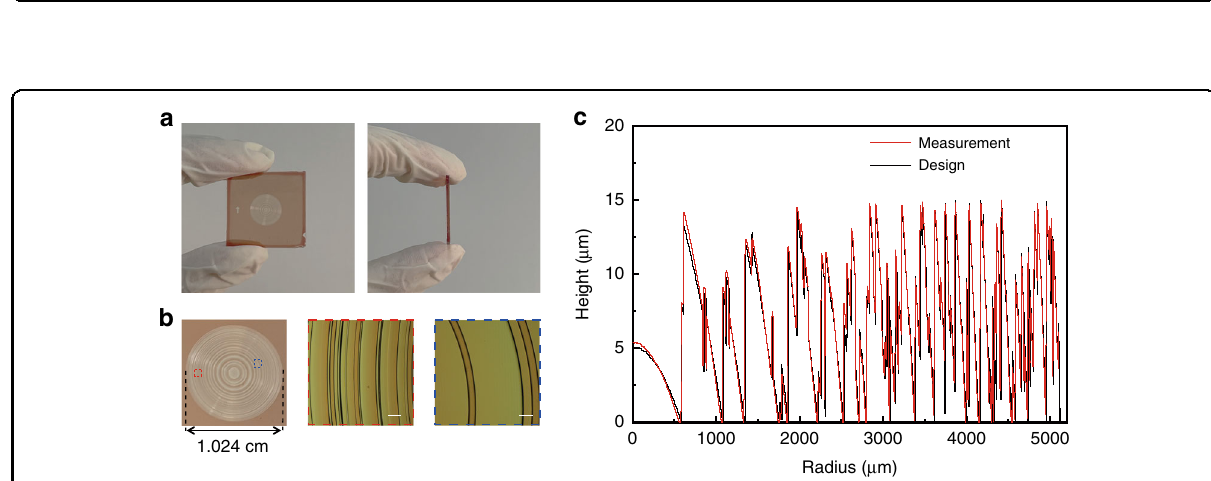
Fig. 3 Fabricated AMDL and characterization. a Photographs of fabricated samples S 3 , the left one and right one are top and side views, respectively. b Local view of the whole AMDL (left) and zoom-in optical image (mid and right). Scale bar, 100 μ m. c The designed (black line) and measured (red line) height distribution,